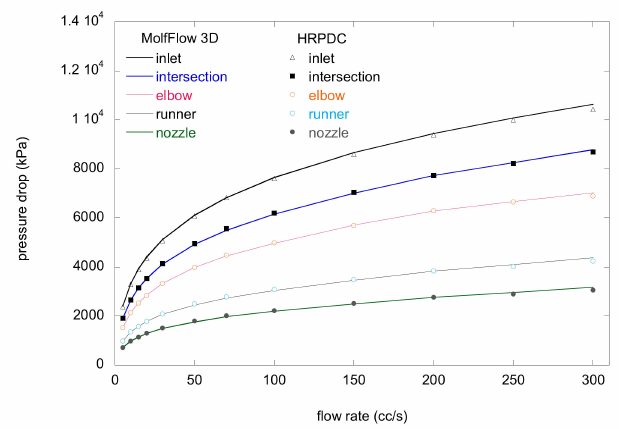
Figure 12. Comparison of the results by HRPDC and MoldFlow at 240 ◦ C for the dimensions in Figure 9.